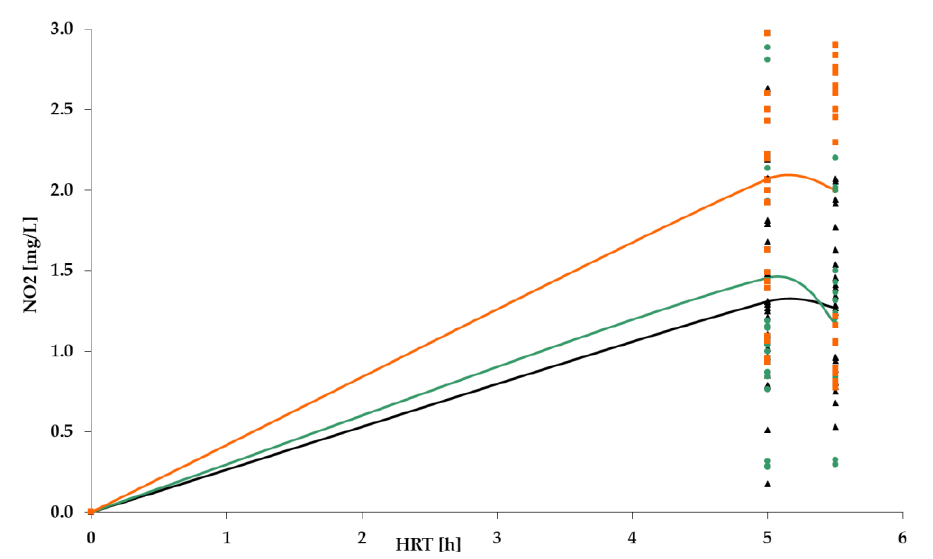
Figure 11. NO 2 concentration dynamics for: PS floating carrier (black); PV floating carrier (green); BB floating carrier (orange).